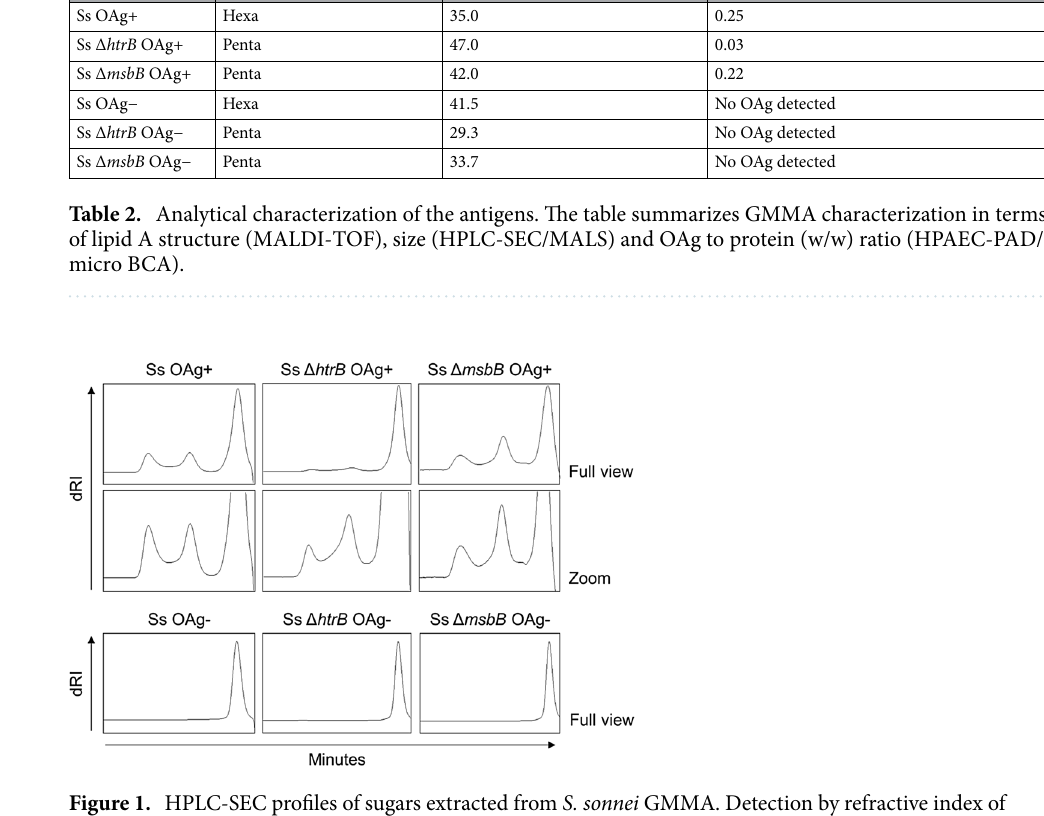
Figure 1. HPLC-SEC profiles of sugars extracted from S. sonnei GMMA. Detection by refractive index of different OAg populations. Results of one representative experiment performed in technical